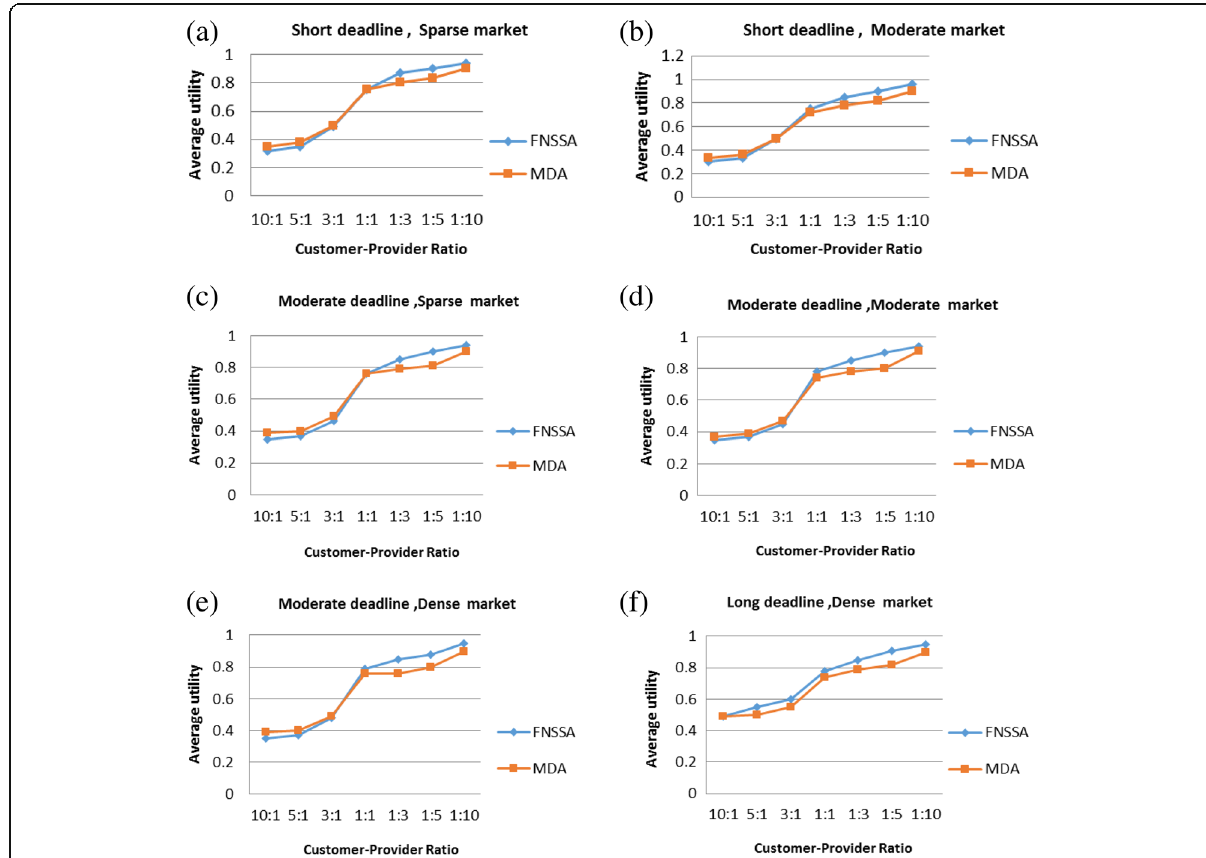
Fig. 5 Average utility of the CRBAs under a short deadline and sparse market, b short deadline and moderate market, c moderate deadline and sparse market, d moderate deadline and moderate market, e moderate deadline and dense market, and f long deadline and dense market. In all figures different market types are